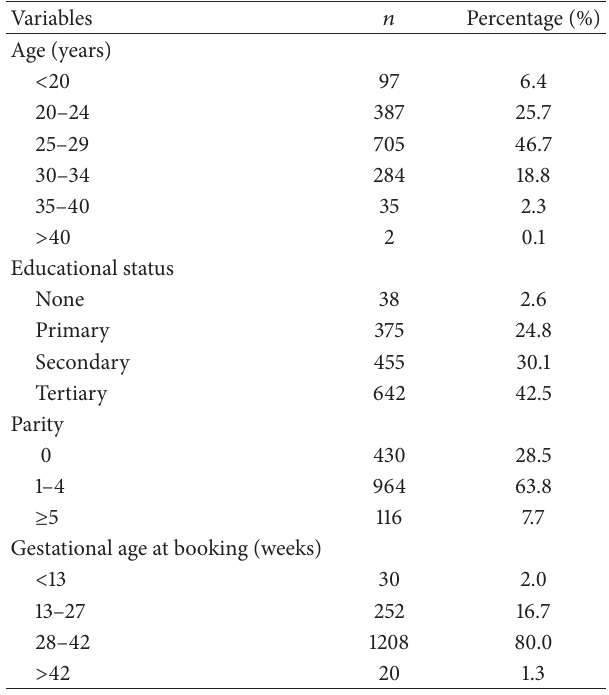
Table 1: Sociodemographic characteristics, parity and gestational age at booking (𝑁 = 1510)